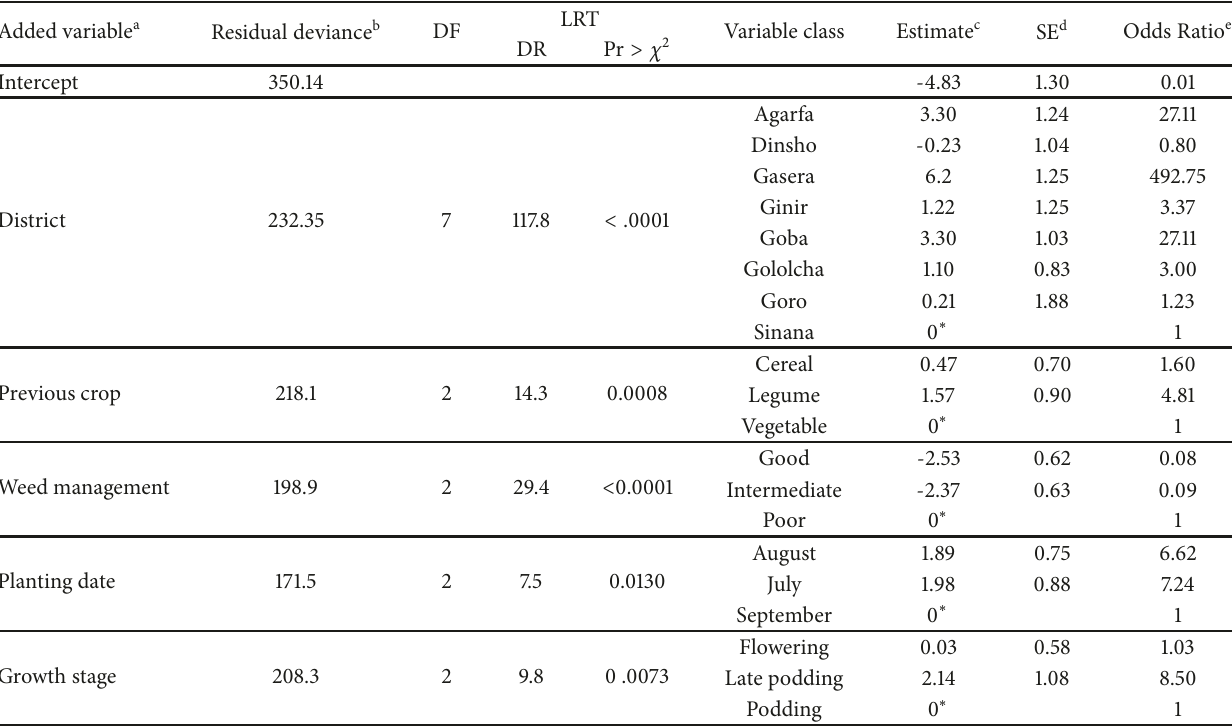
Table 8: Analysis of deviance, naturallogarithms of odds ratio, and standard error of added variables in a reduced model analyzing faba bean rust